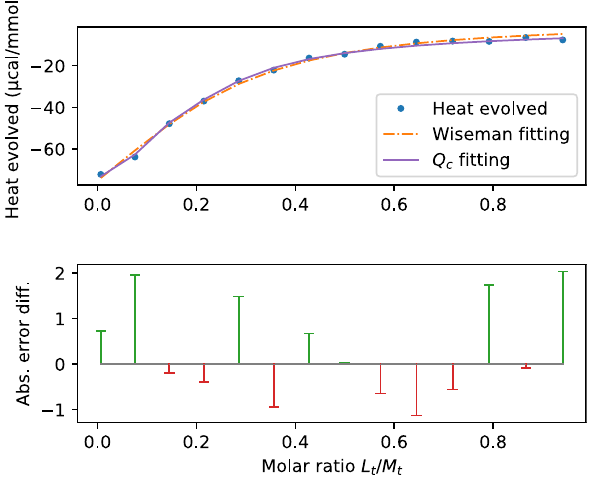
Figure 2. ( a ) Integrated heat per injection over molar ratio with Wiseman graphs of Wiseman and Q c fitting for the bivalent case. ( b ) Difference of absolute error plots from Wiseman and Q c fitting.